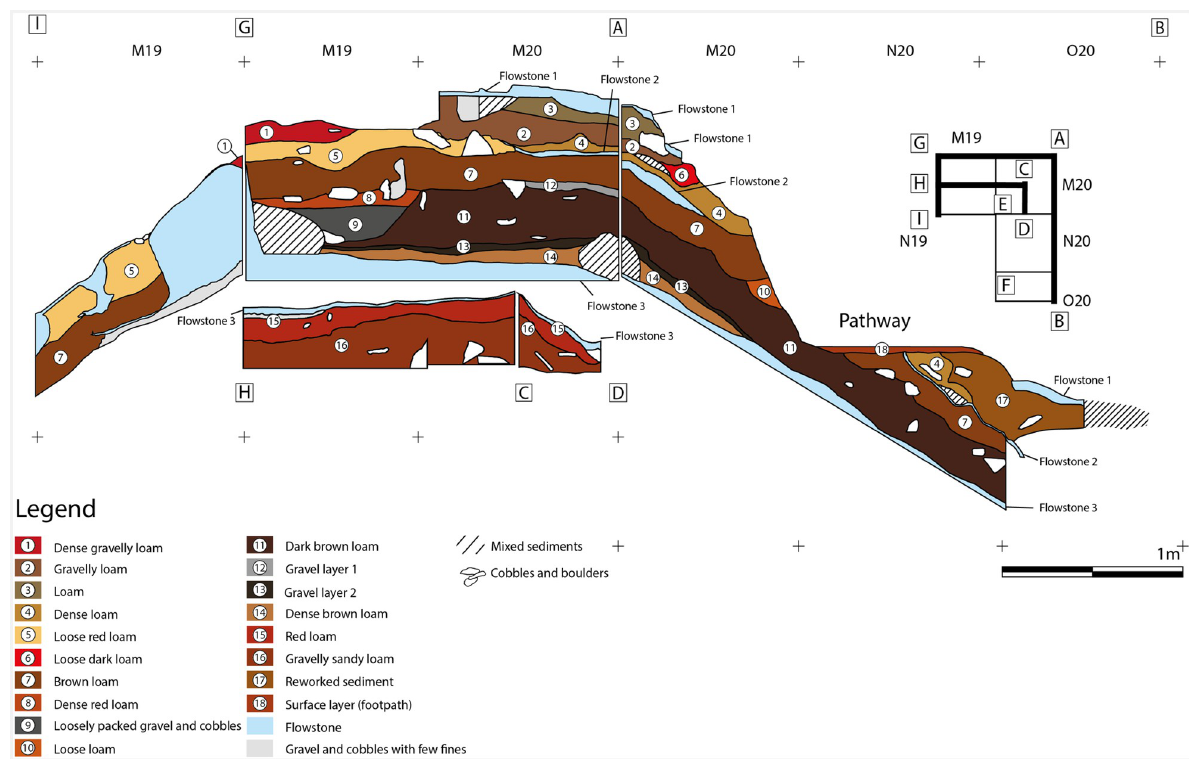
Fig 6. Zone 2 sections.